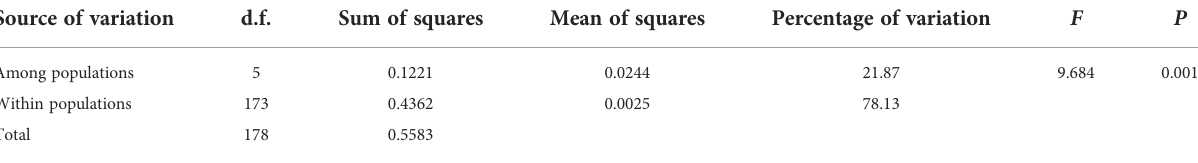
TABLE 2 Non-parametric analysis of variation for 18 leaf traits of T. fuana in six populations. Source of variation d.f. Sum of squares Mean of squares Percentage of variation F P